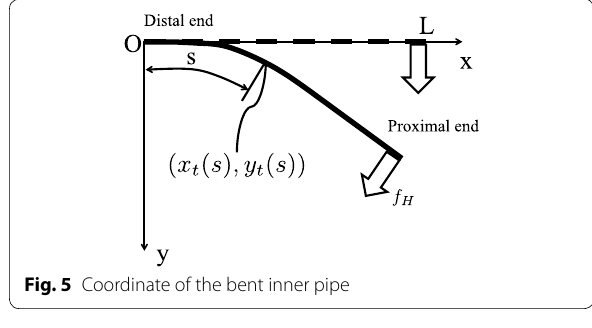
Fig. 5 Coordinate of the bent inner